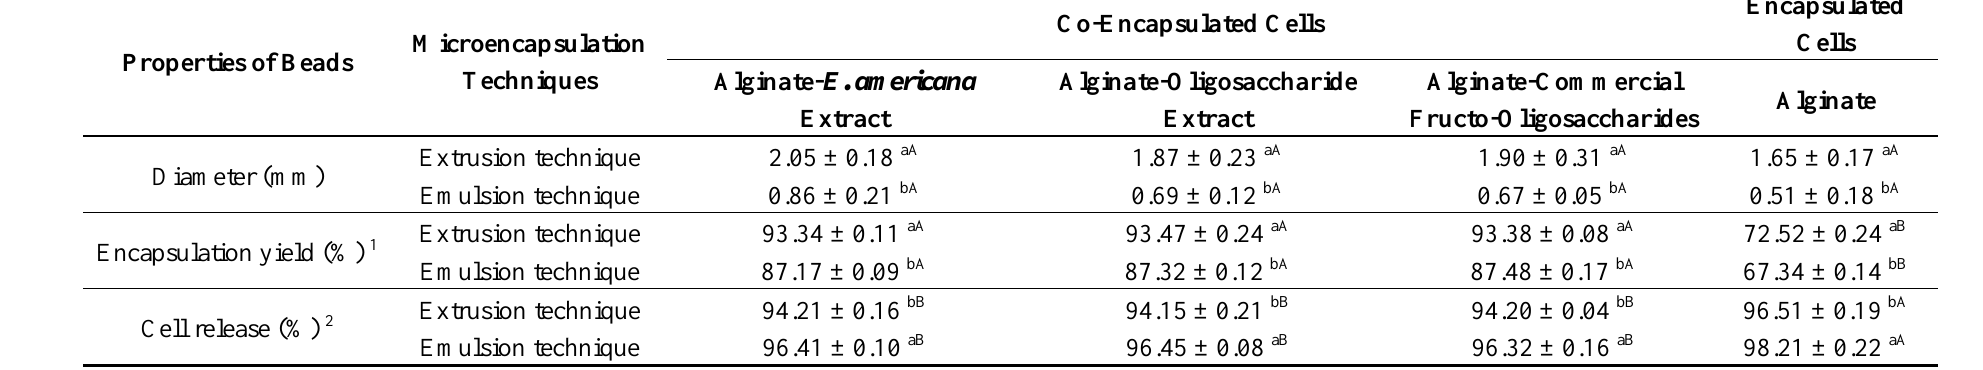
Table 2. Diameter, encapsulation yield (%) and cell release (%) of microencapsulated Bifidobacterium longum with Eleutherine americana.